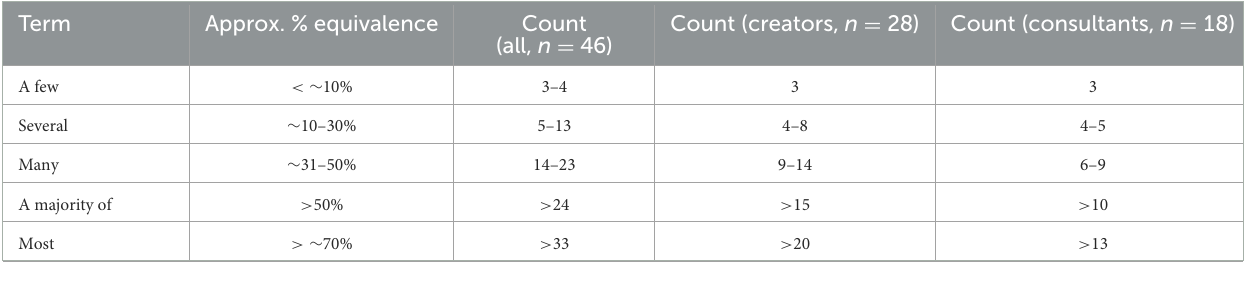
TABLE 2 Hollywood creator/consultant perceptions of FiSci ( n =